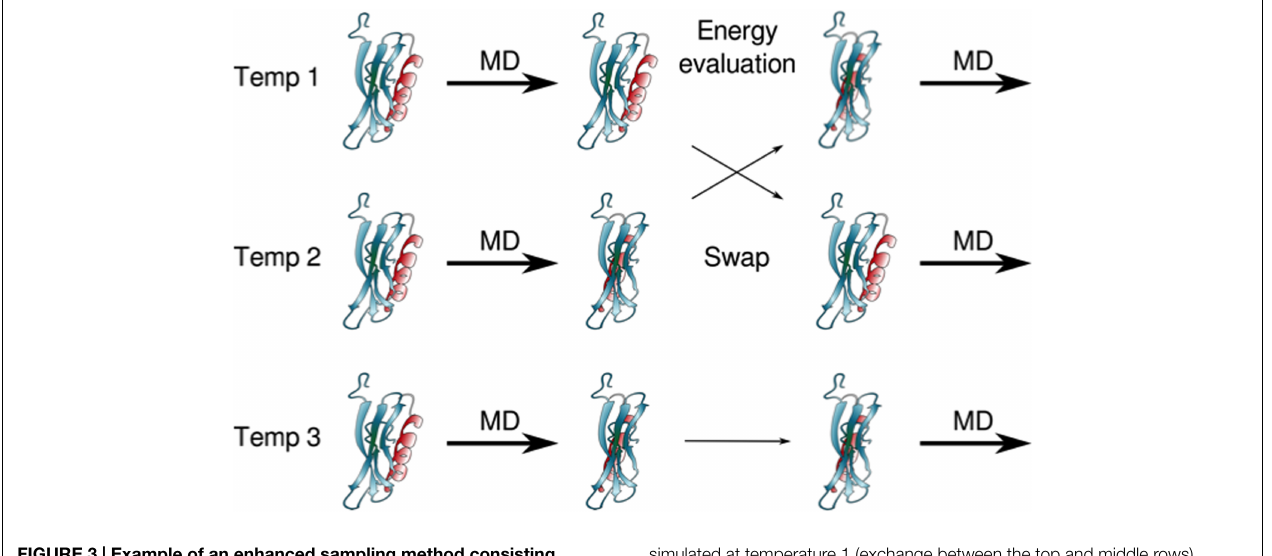
FIGURE 3 | Example of an enhanced sampling method consisting on multiple MD simulation replicas at different temperatures (each row). At defined time intervals, which can vary typically from a few to hundreds of ps, the energy of the structures of each replica are evaluated. If the energy of run 1 is lower than that of run 2, or if it is higher but allowed by the Boltzmann factor, the replicas are exchanged, so now the structure from run 1 is simulated at temperature 2, and the structure from run 2 is